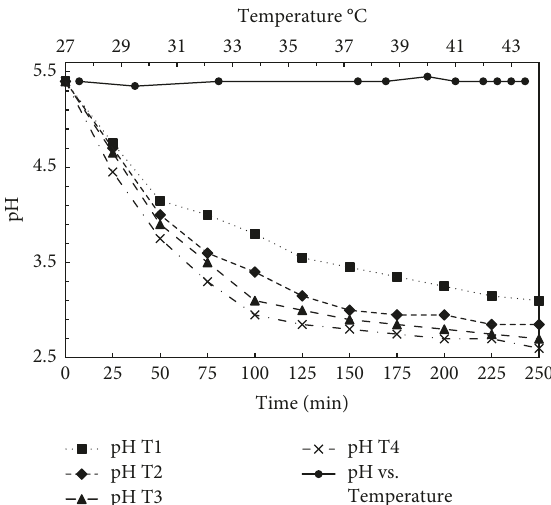
Figure 5: pH of the diethyl (3H-1-ethoxy-3-phenoxazinylidene) ammonium chloride solution as a function of plasma exposure time, treatment, and